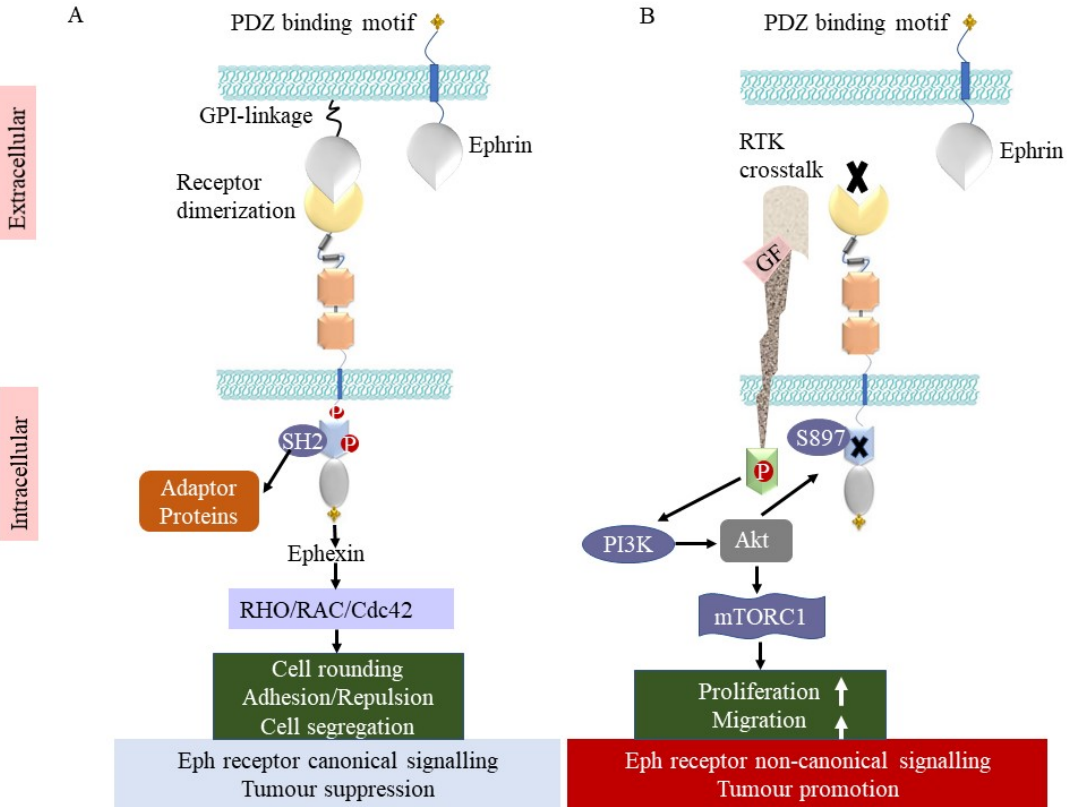
Figure 2. Tumour-suppressing and tumour-promoting functions of Eph receptors. ( A ) Interaction of Eph receptor and ephrin on neighbouring cells causes clustering of Eph–ephrin complexes and the beginning of canonical signalling. The activation of Eph kinase function involves tyrosine phos- phorylation and recruitment of adaptor proteins, including SH2-domain-containing signalling pro- teins. In reaction to ephrin-A, ephexin stimulates RhoA, which induces cytoskeletal remodelling, cell retraction and segregation, and membrane blebbing. ( B ) In the absence of ephrin, Eph receptor expression can lead to noncanonical signalling, whereby crosstalk between Eph receptors and other RTK activity induces phosphorylation of Akt by the lipid kinase PI3K. Akt then phosphorylates EphA2 at S897 to enhance cellular proliferation, cell migration, and reduce apoptosis through sev- eral downstream effectors, including mTOR complex 1. RTK activity induces phosphorylation of Akt by the lipid kinase PI3K. Akt then